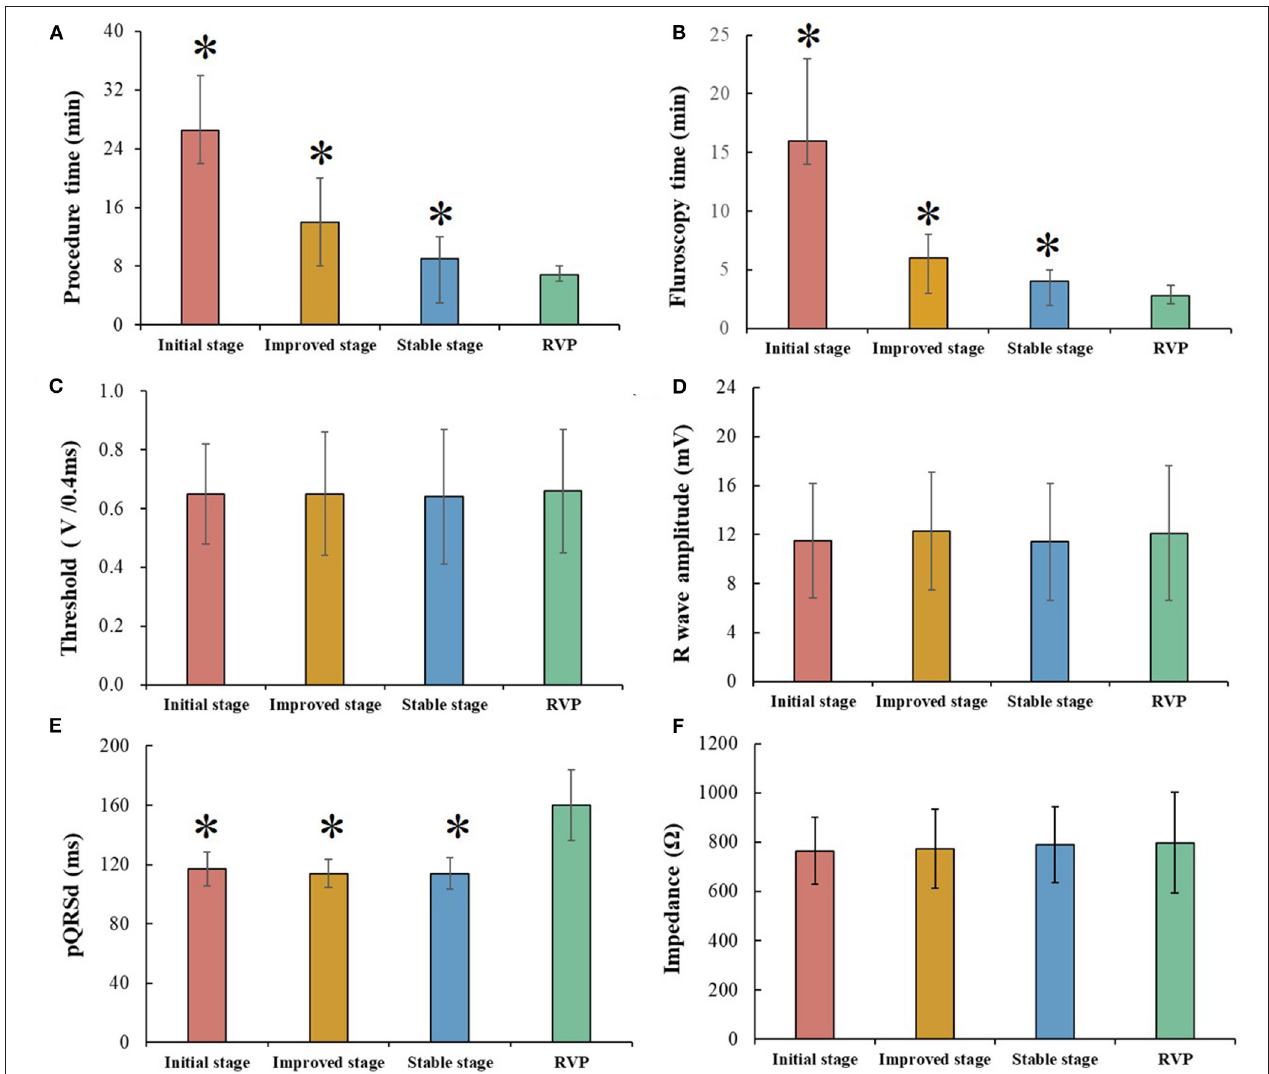
FIGURE 2 | Comparison between different left bundle branch area pacing (LBBAP) stages and right ventricular pacing (RVP). ( A,B) Procedure time and fluoroscopy time gradually decreased among three LBBAP stages but still longer than that of RVP. ( C,D,F) Pacing parameters, including, capture threshold, R wave amplitude, and impedance, were comparable among three LBBAP stages and RVP. ( E) LBBAP produced a narrower pQRSd than RVP; * P < 0.05 compared with